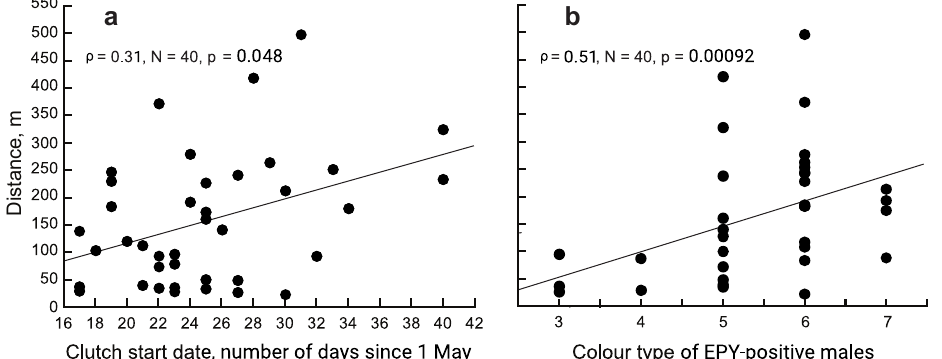
Figure 5. The distance between the nests of extra-pair mates depending on breeding timing of males (estimated as the clutch start date of within-pair female) ( a ) and the Drost’s colour type of the male breeding plumage ( b ). The order of the categories of this scale denotes the degree of melanization of the upper-body feathers in the male breeding plumage and overall plumage brightness. Males of type 1 are the most conspicuous because of the deep black colouration of the body top and purely white colouration of the body bottom. Males of type 7 are most cryptically coloured because of the brown body top and dirty brownish-white body bottom. The colouration of breeding plumage of males of type 7 is practically identical to that of females. The value of Spearman’s correlation coefficient ( ρ ), sample size (N) and significance level ( p ) are given. Linear regression (solid line) is